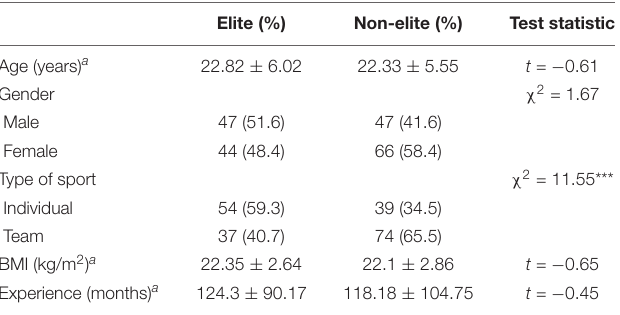
TABLE 1 | Socio-demographic characteristics of elite and non-elite athletes and assessment of their differences according to age, gender, type of sport, BMI, and